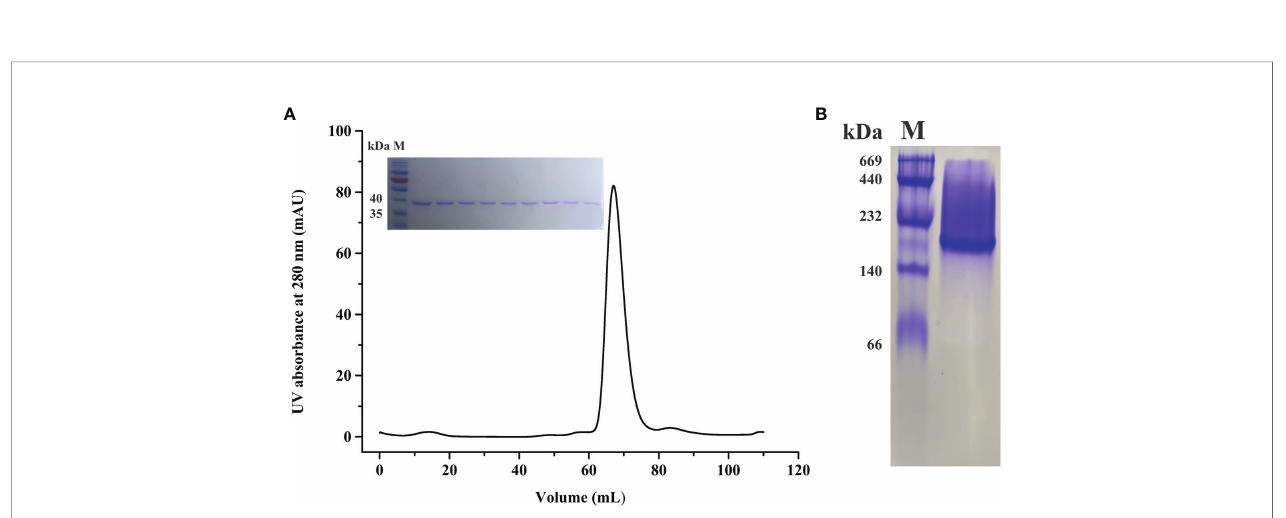
FIGURE 2 | Molecular sieve chromatography and protein gel analysis for rBoLDH. (A) A representative peak diagram of sieve chromatography (Superdex 200 pg). The illustration showed the separation effect of rBoLDH examined by 12% SDS-PAGE. (B) 8% Blue native-PAGE analysis for rBoLDH. Lane M: High molecular weight marker (GE Healthcare, Uppsala, Sweden).